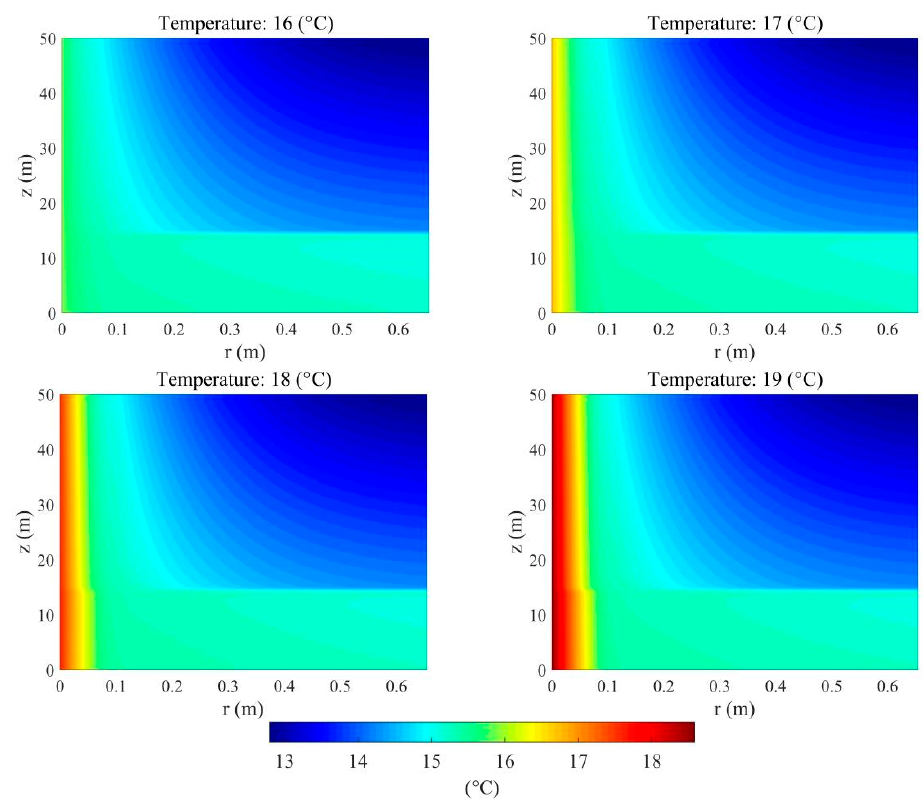
Figure 9. Comparison of two-dimensional water saturation distribution of hydrate reservoirs for a fixed salinity of 3.05 wt% at the 24th hour of drilling fluid invasion under different drilling fluid temperatures.